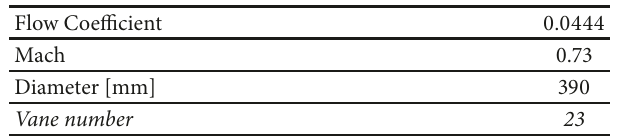
Table 1: Specification of analyzed